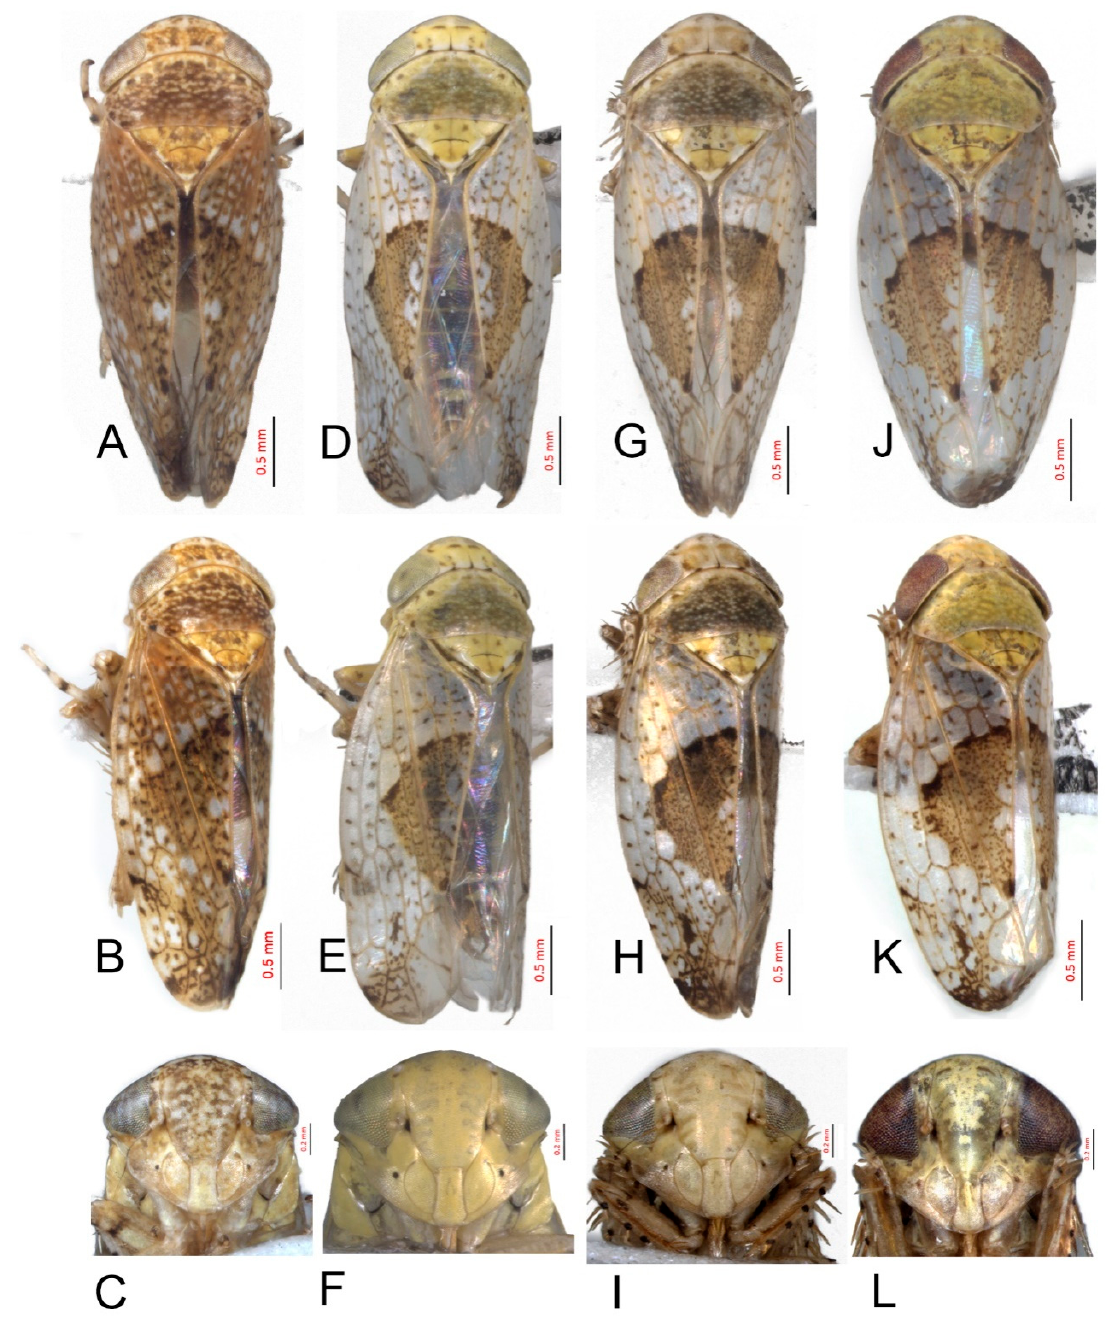
Figure 2. Species of Hishimonus . ( A – C ) H. aberrans ; ( D – F ) H. knightiellus ; ( G – I ) H. tenuis ; and ( J – L ) H. subtilis . ( A , D , G , J ) Dorsal view; ( B , E , H , K ) latero-dorsal view; and ( C , F , I , L ) Face.